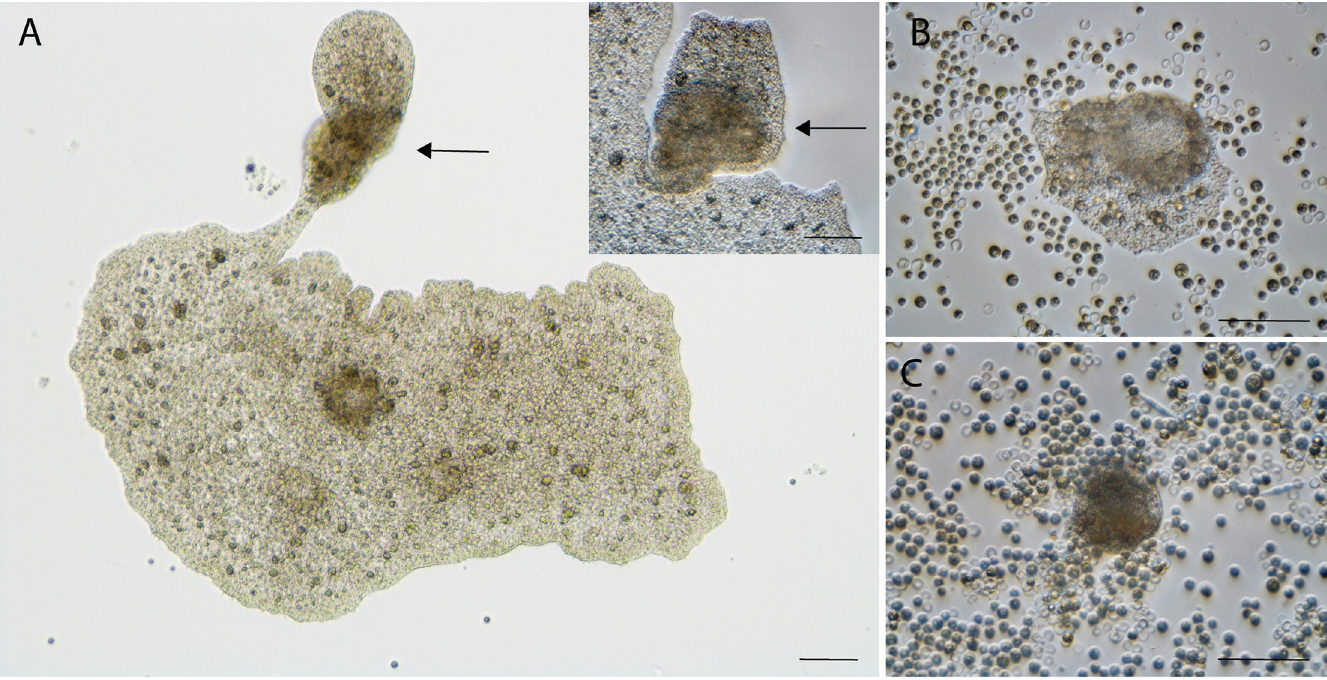
Fig 3. Cell extrusion after radiation exposure. (A) Extrusion (arrows) of brownish putative cancer-like cells; insert, magnification of the same extrusion. (B) The cancer-like cells and the normal cells detached from the main body formed a new animal. The extrusion was observed and isolated 37 days after X-ray exposure. (C) Over time, the clear, apparently normal cells of the extruded body reduce in number, leaving only the apparently damaged cells, which eventually died. This specimen was exposed to 143.6 Gy X-rays. (A) Bright field, insert; (B and C) DIC, scale bars = 50 μ m. DIC, differential interference contrast.